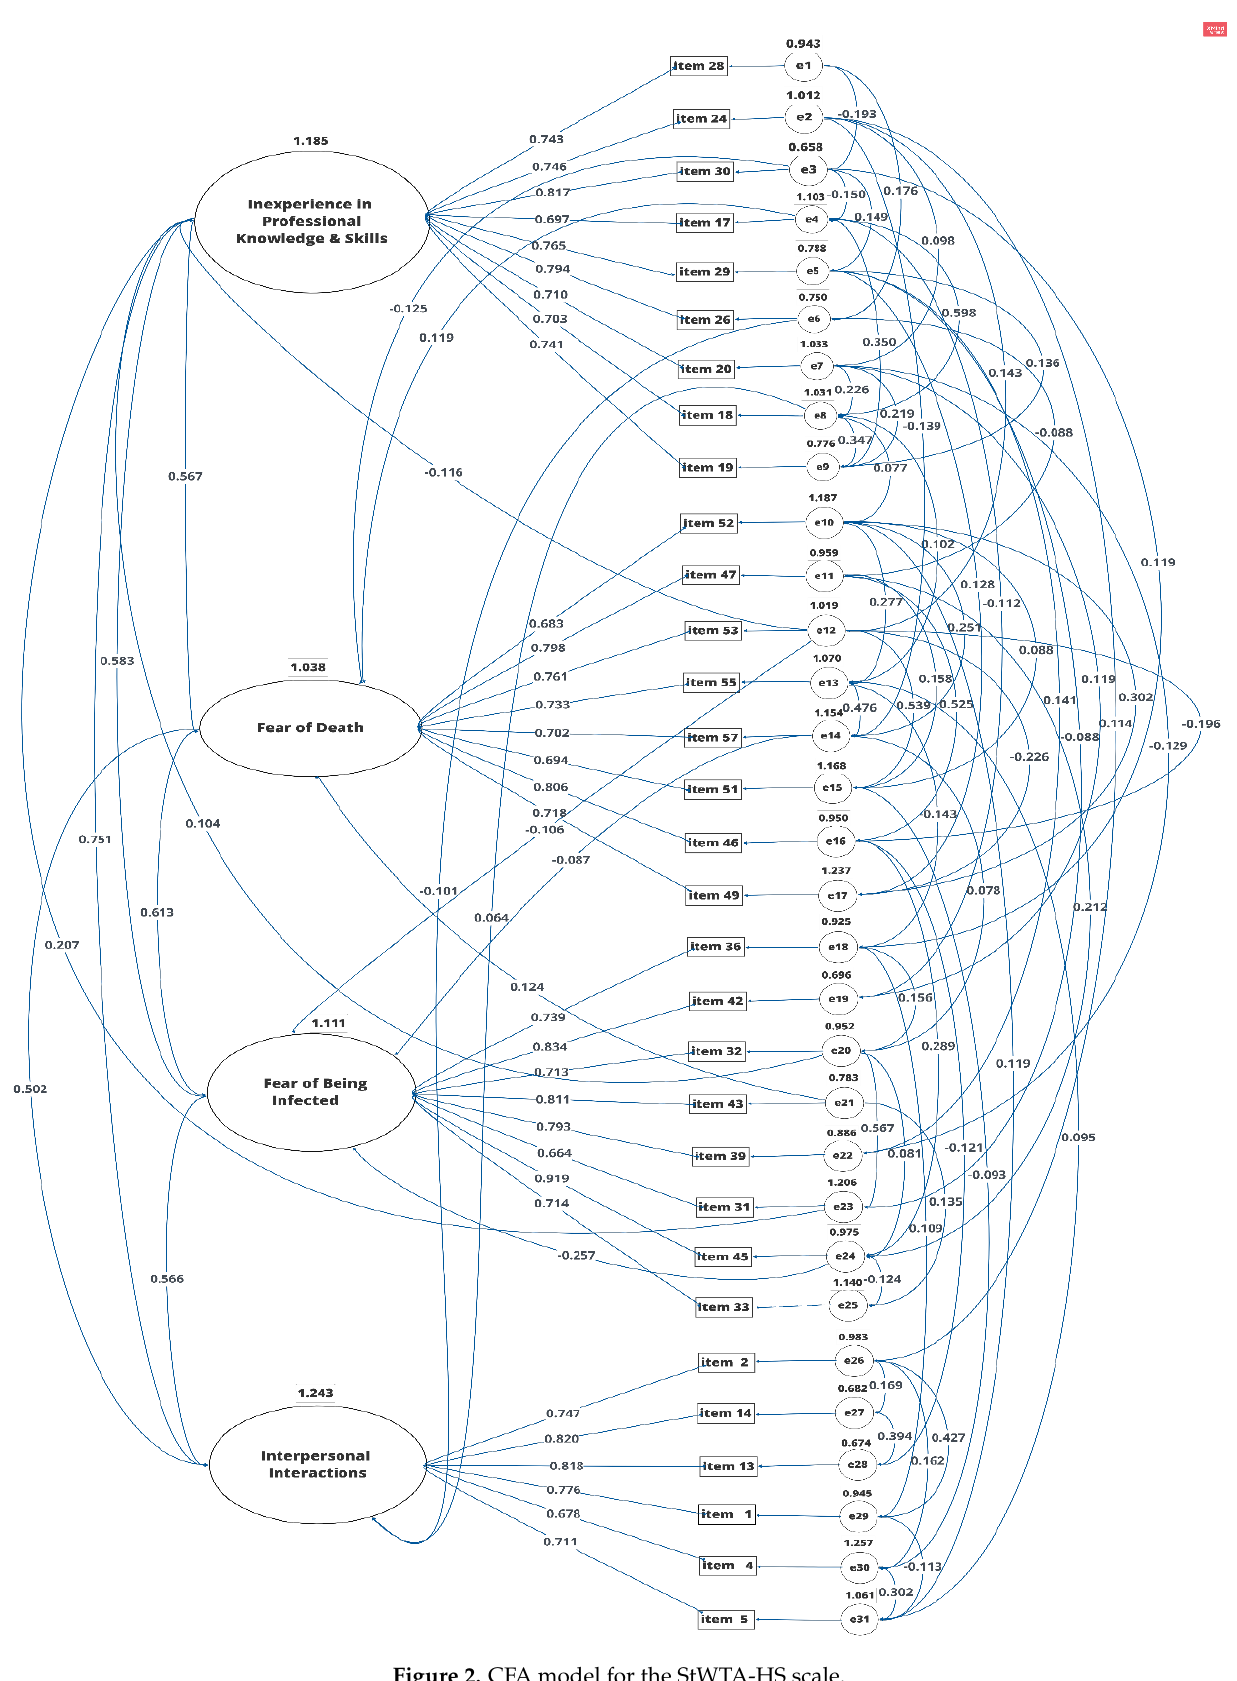
Figure 2. CFA model for the StWTA-HS scale.